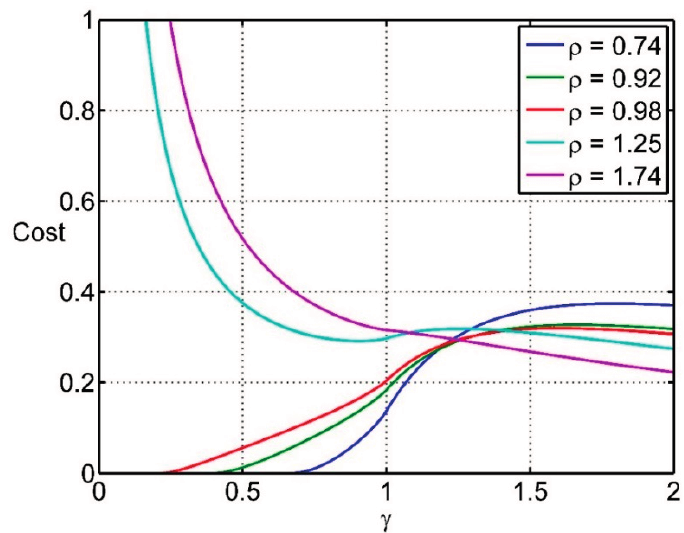
Figure 13. An illustration of a simple cost function applied to the targeting problem.